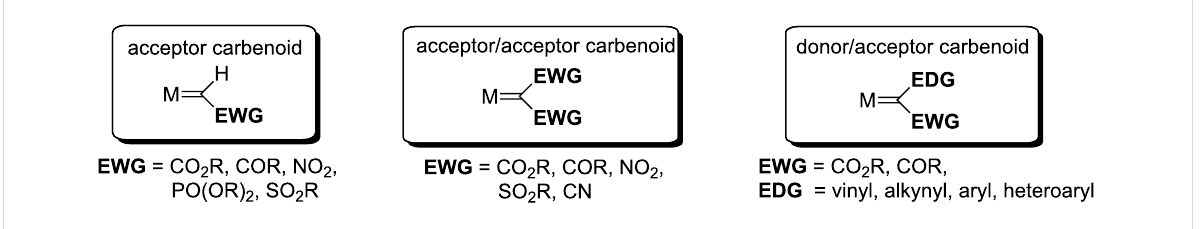
Figure 2: Classification of the carbenoid intermediates by the electronic nature of the groups attached to the divalent carbene carbon.